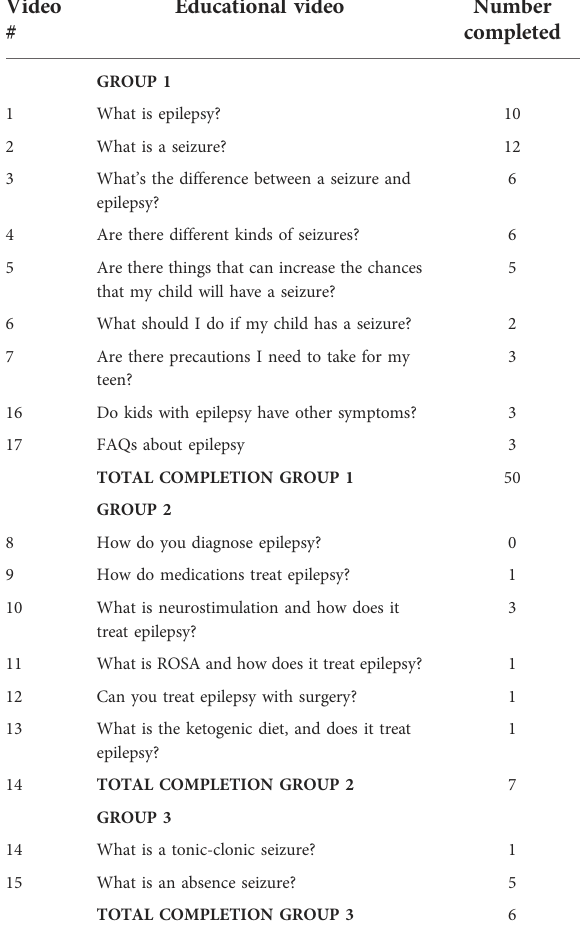
TABLE 1 Epilepsy videos and number of families who completed each